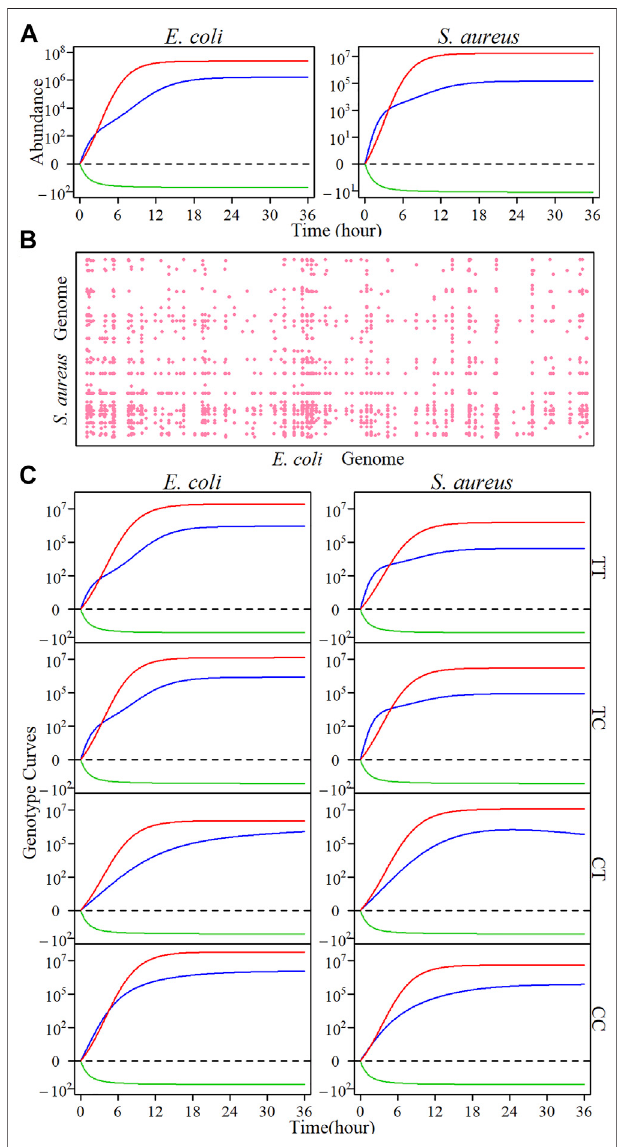
FIGURE4| Thetwo-dimensional genetic analysisresults ofinterspecies interactions between E. coli and S. aureus in community growth. (A) The overall microbial abundance (blue line) of E. coli and S. aureus in co-culture, and the underlying independent (red line), and interactive (green line) growth components. (B) Two-dimensional Manhattan plots of signi fi cant QTL pairs on two microbial genomes. The genome-wide signi fi cance threshold is determinedby10 − 6 signi fi cancelevelafterBonferronicorrection. (C) Microbial growth curves of four genotype combinations T/T, T/C, C/T, and C/C formed by QTL E4320079 from E. coli and S188004 from S. aureus .